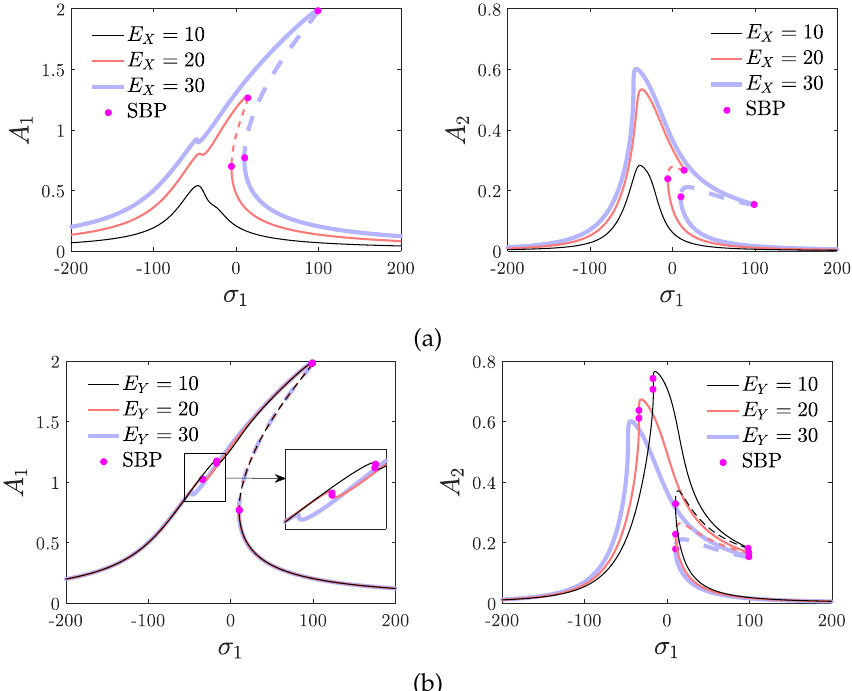
Figure 7. Effects of driving and detecting voltages on the response of the micro-machined gyroscope. ( a ) The effects of driving voltage ( E Y = 30 ) . ( b ) The effects of detecting voltage ( E X = 30 ) . SBP denotes the saddle–node bifurcation point.